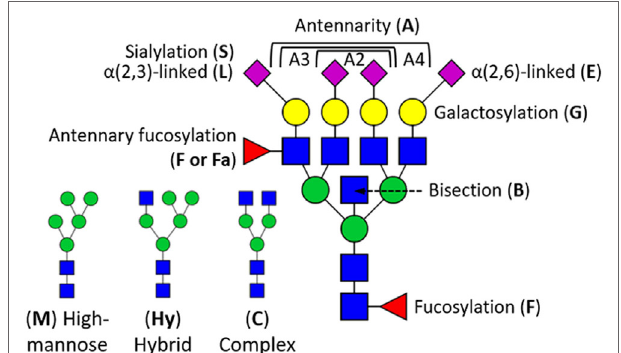
FigUre 1 | Schematic overview of glycosylation traits derived from human serum proteins. N -Glycan structures are generalized into high-mannose type (M), hybrid type (Hy), and complex type (C) by the number of mannoses (green circle) and antennary N -acetylglucosamines (blue square). High- mannose-type N -glycans can have up to nine mannoses, whereas each antennary N -acetylglucosamine can be terminally substituted with a galactose (yellow circle), and sialic acid (magenta diamond). Sialic acids (S) can either be α 2,3-linked (L) or α 2,6-linked (E). N -Glycans can further be modified with a fucose (F), optionally at an antennary N -acetylglucosamine (Fa), and structures may as well be bisected (B). In case of derived traits, the subject of the calculation is represented by the last letter, e.g., sialylation (S), and the group on which it is calculated by the preceding letters, e.g., triantennary fucosylated species (A3F). This, for instance, translates A3FGS into the sialylation per galactose within triantennary fucosylated species.